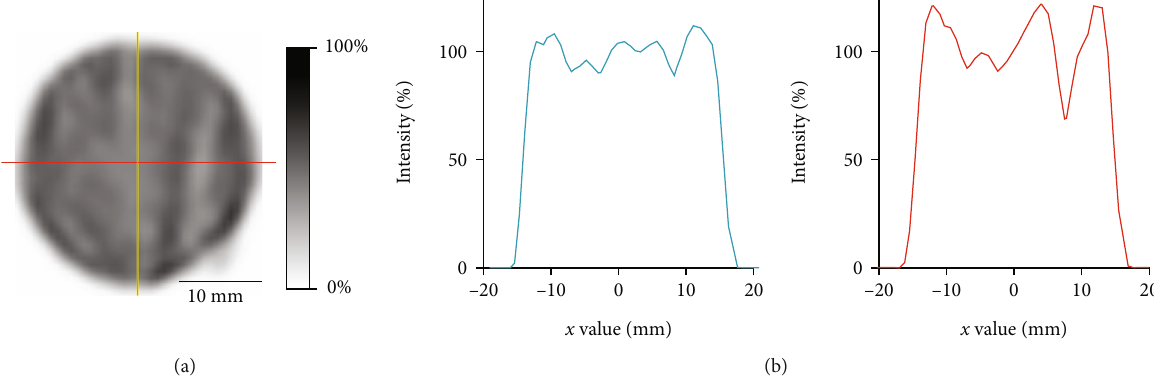
Figure 3: Representative image and line pro fi les of the cylinder phantom for uniformity. (a) Transaxial SPECT image. The activity concentration was 20.5MBq/mL. Slice thickness of 5.0mm and Gaussian post fi lter full width at half maximum (FWHM) equal to maximum resolution of 2.5mm were applied. (b) Line pro fi les of the vertical and horizontal lines on the left SPECT image. Blue and red curves are corresponding to the blue vertical and red horizontal